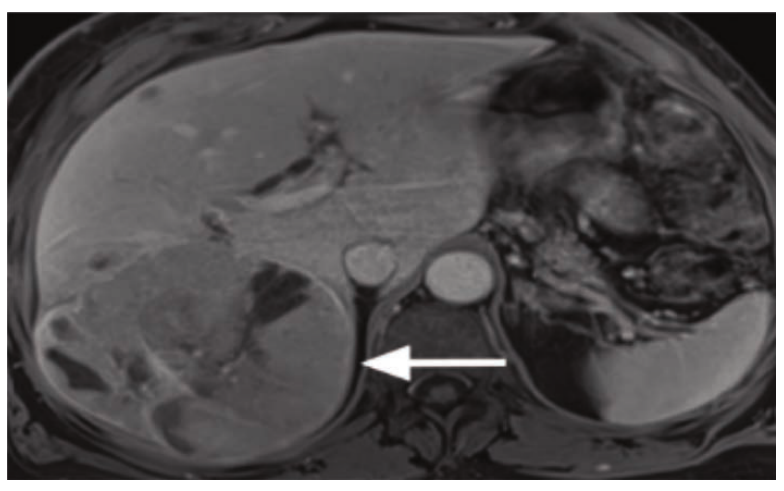
Figure 3. Magnetic resonance imaging axial T1 Dixon water post gadolinium image shows a large, heterogeneously enhancing mass (arrow) in the right lobe of the liver with central